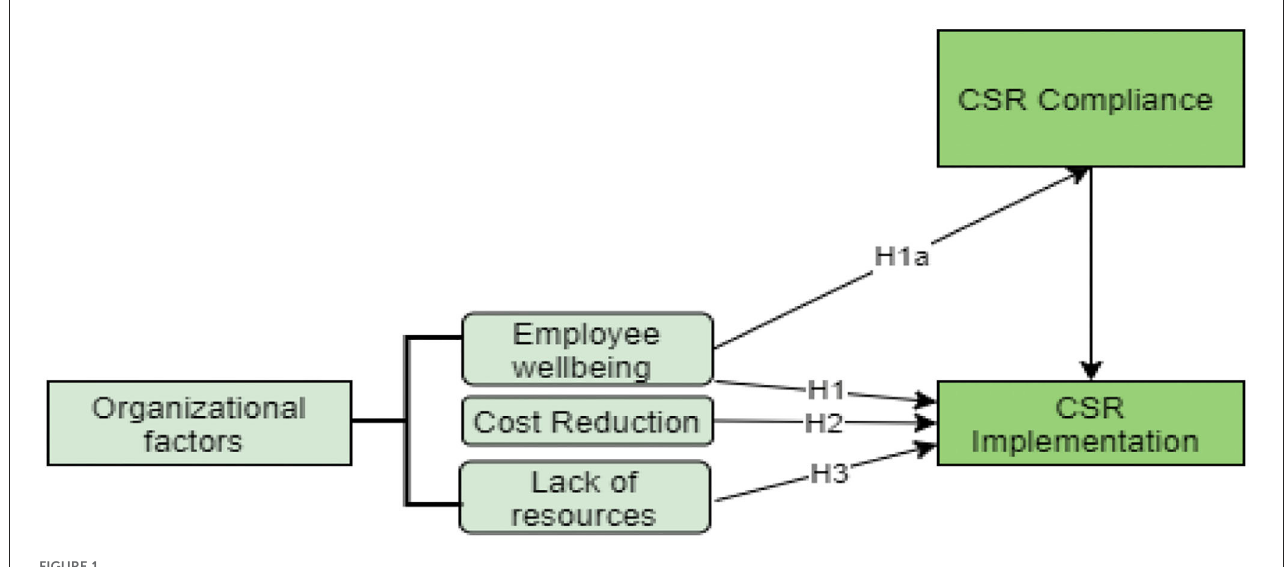
FIGURE1 Conceptual